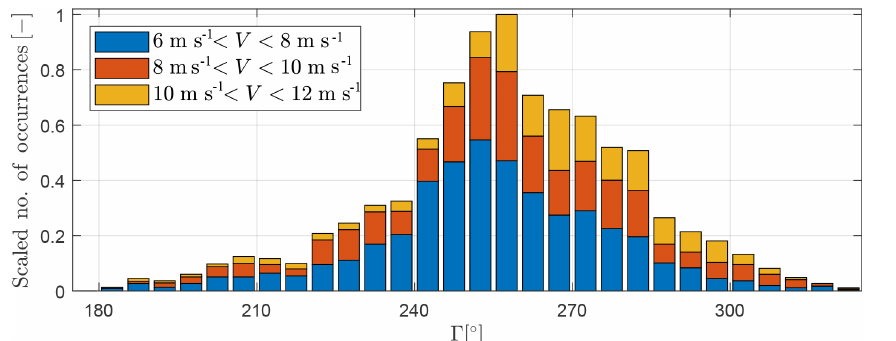
Figure 13. Scaled number of measurement data points (10min mean) within each speed and direction bin.